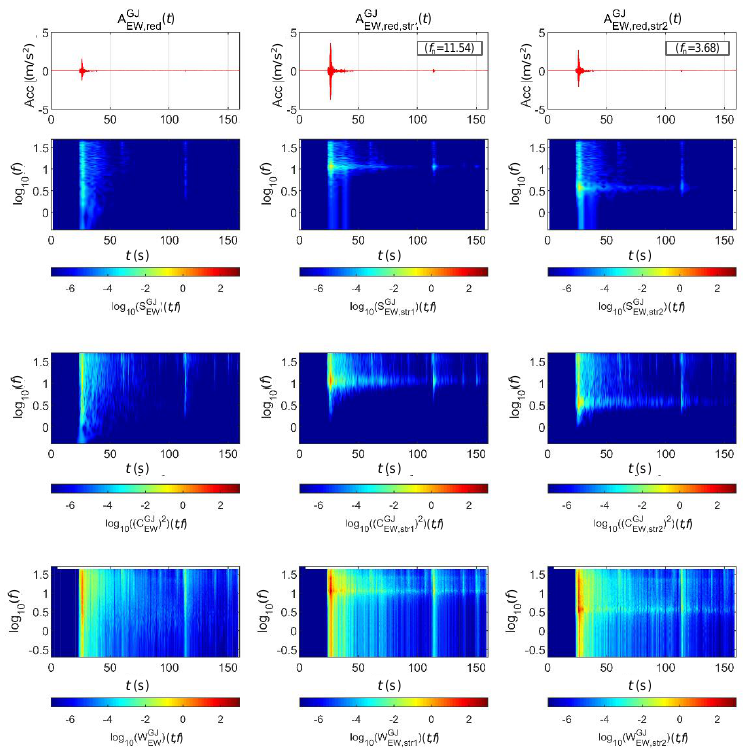
Figure 13. Analysis results of the Gyeongju earthquake data (scaled for 1000-year return period) and associated bridge responses.